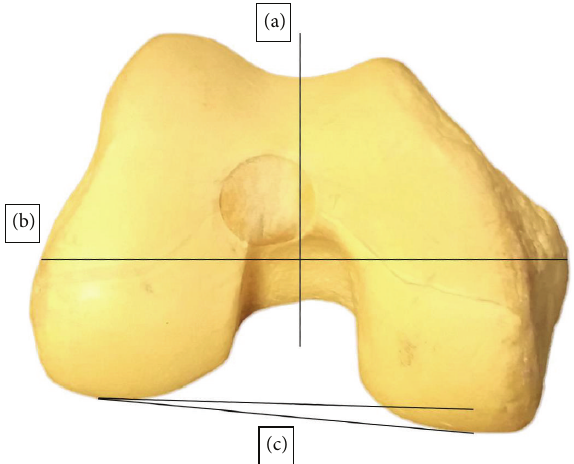
Figure 1: After registration of bony landmarks, that is, most anterior trochlear groove, most distal trochlear groove, medial and lateral epicondyle, and most posterior medial and most posterior lateral point via a computer-assisted navigation system, establishing femoral rotation can be based on 90 ∘ angle from anterior-posterior midline or “Whiteside’s line” (a) or be based on anatomical transepi- condylar axis (b). The conventional method uses the posterior condyles as a reference and prescribes three degrees’ rotation